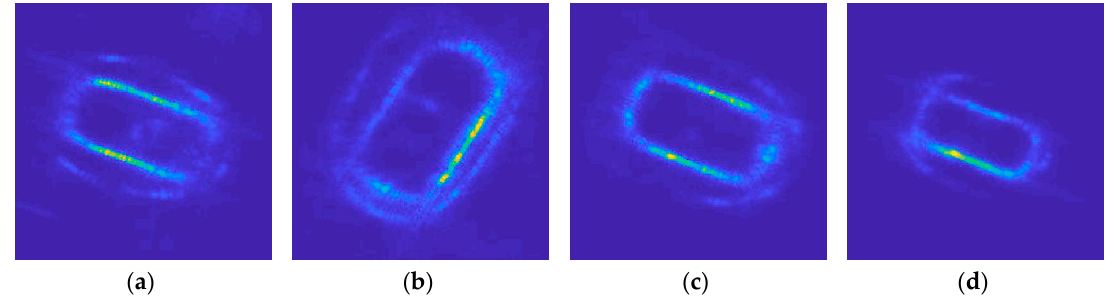
Figure 3. Example of results after the gravitation-based speckle reduction algorithm of Figure 2e–h. The corresponding vehicle models are: ( a ) Chevrolet Impala LT; ( b ) Mitsubishi Galant ES; ( c ) Toyota Highlander; and, ( d ) Chevrolet HHR LT.